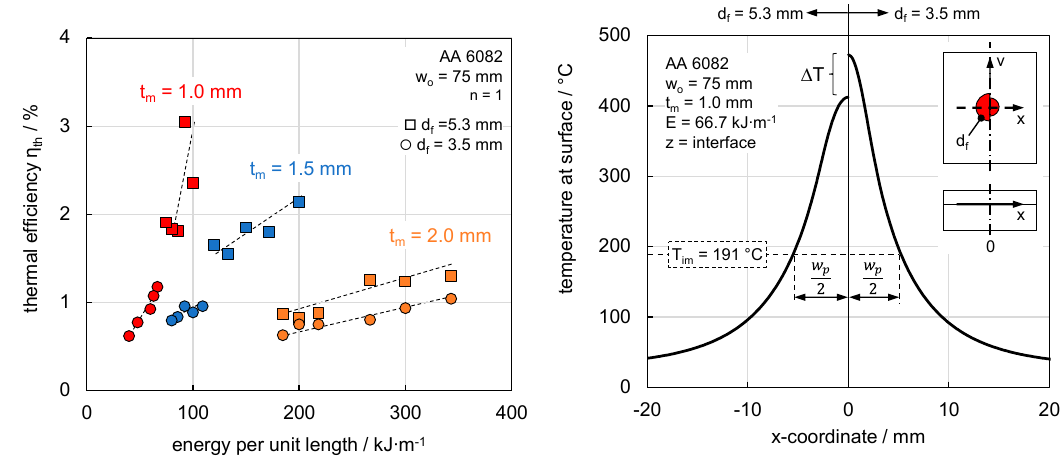
Figure 5. ( a ) The dependence of thermal efficiency on energy per unit length for various sheet thicknesses and focal diameters for the aluminium alloy AA 6082 and ( b ) temperature distribution in the interface for different focal diameters based on numerical simulation.